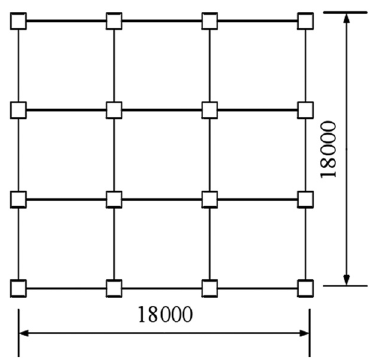
Figure 5: Layout plan.